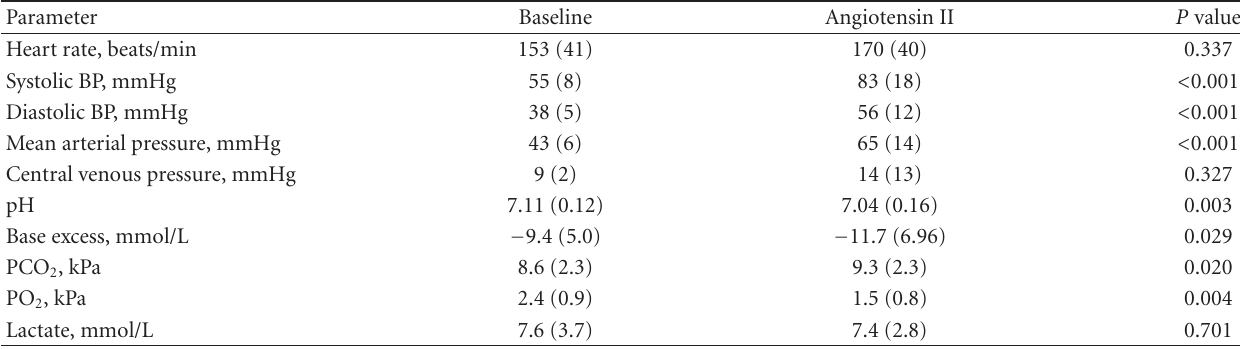
Table 2: Invasively monitored fetal hemodynamic parameters and acid-base status at baseline and during angiotensin II infusion. Data are presented as mean (SD).